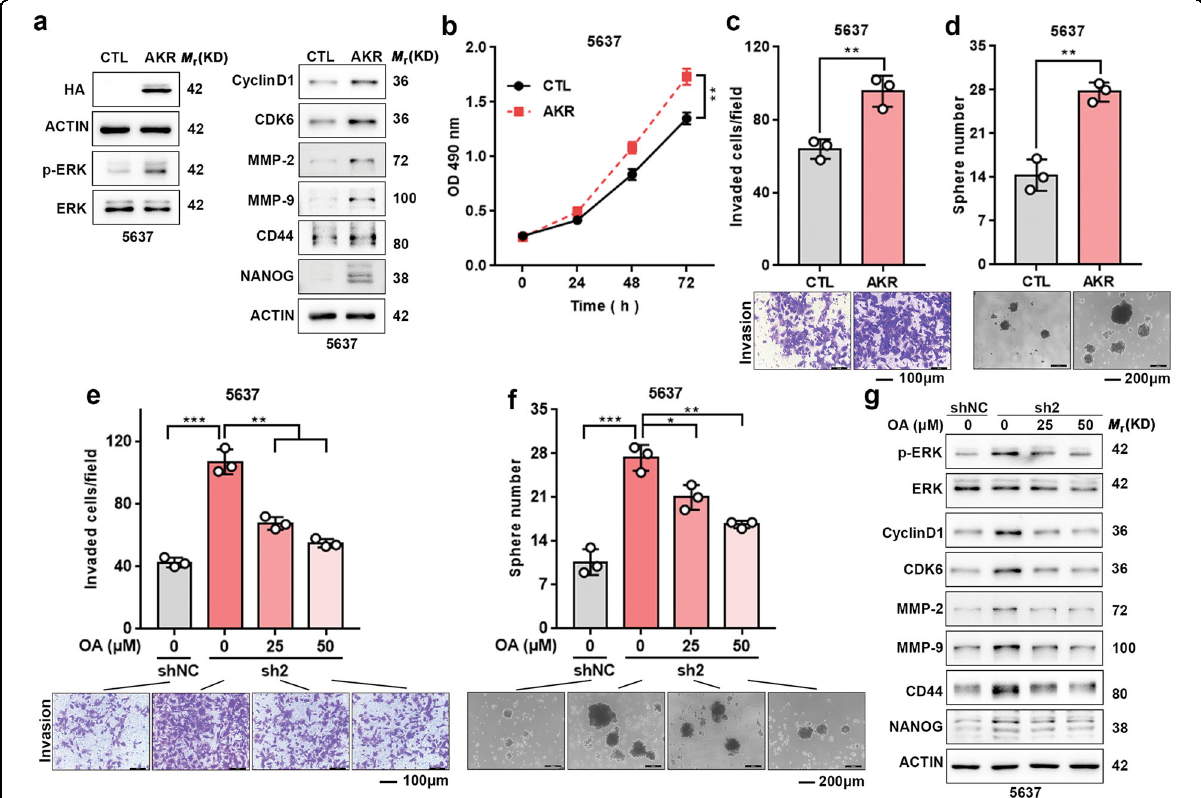
Fig. 6 AKR1B10 promotes UBC progression and oleanolic acid inhibits UBC progression via suppressing the AKR1B10 – ERK signaling. a Western blotting was performed to examine genes expression in AKR1B10 overexpression 5637 cells. b – d Effects of AKR1B10 overexpression on cell viability, invasion, and sphere formation in 5637 cells. e , f CBX7 knockdown increased invasive ability and the size and number of spheres in 5637 cells, whereas this effect was abolished upon AKR1B10 inhibition by OA at dose of 25 and 50 μ M after treated 72 h. g Western blotting was performed to detect genes expression in CBX7 knockdown 5637 cells treated with OA at dose of 25 and 50 μ M after treated 72 h. Scale bar, 100 μ m ( c , e ); 200 μ m ( e , f ). Data are presented as means ± SD from three independent replicates. * p < 0.05, ** p < 0.01, *** p <